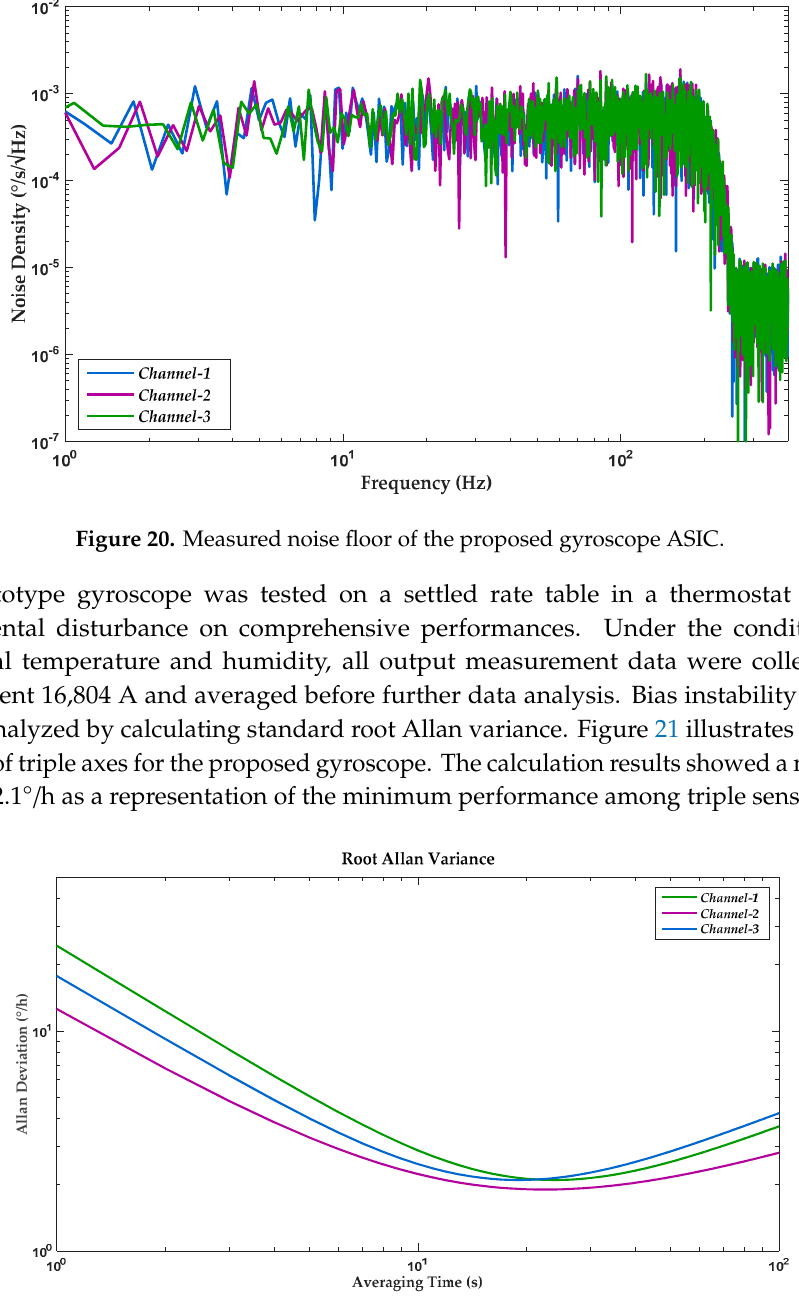
Figure 19. Measured DC transfer function.